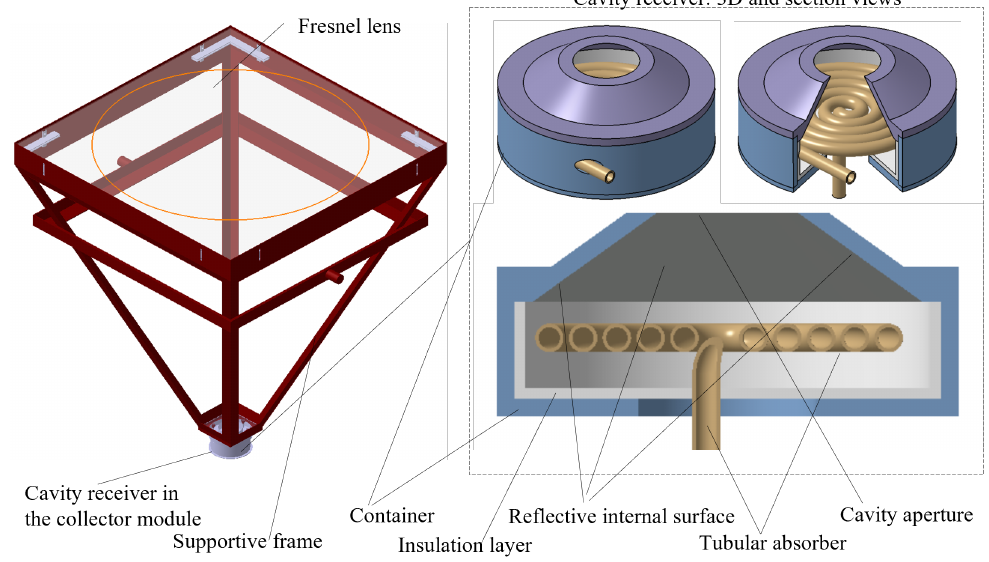
Figure 2. Schematic view: the collector module and the conical cavity receiver. ( Left ): the collector module; ( right ): section views of the cavity